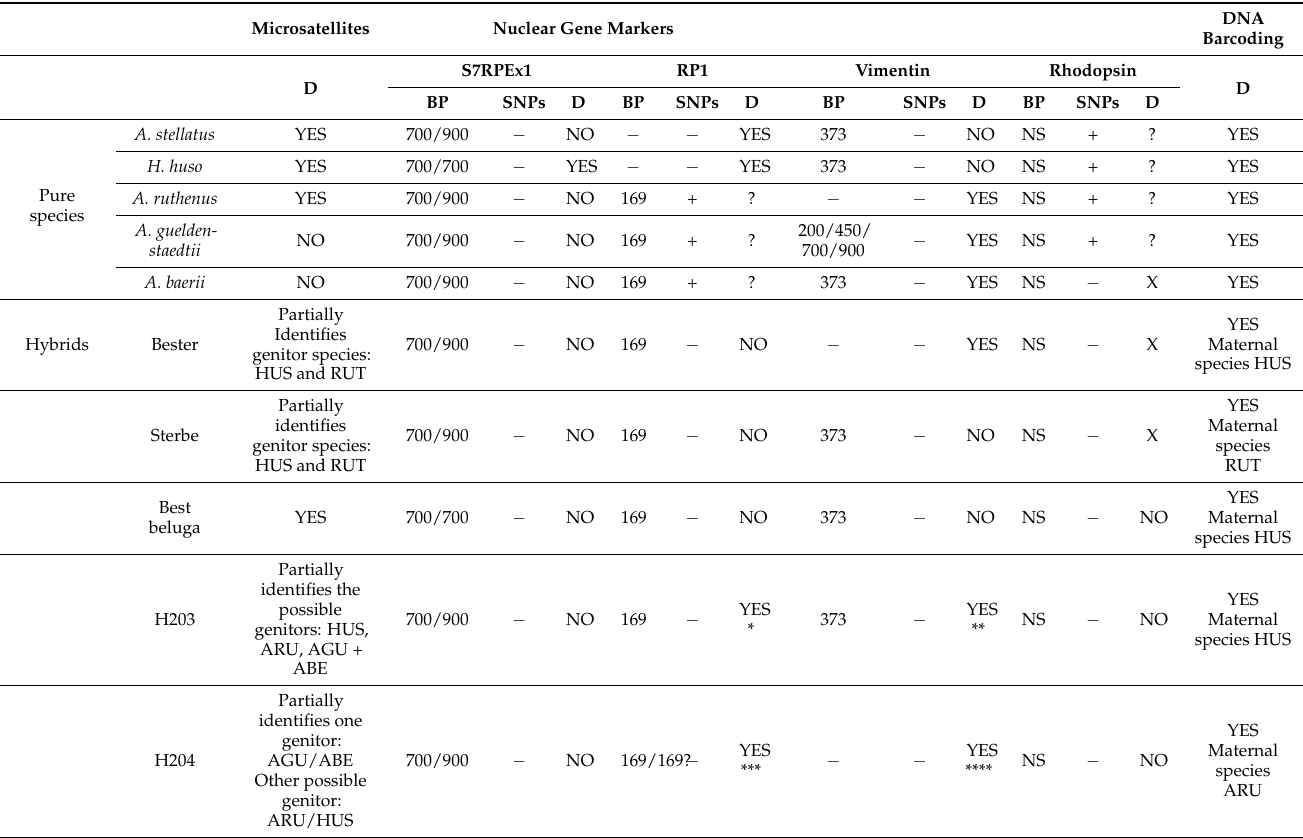
Table 6. Data integration for all DNA markers. Each marker is evaluated for its accuracy in pure species and hybrid identification. D—diagnostics value; BP—band pattern; NS—not specific (band pattern); ?—ambiguous (needs further